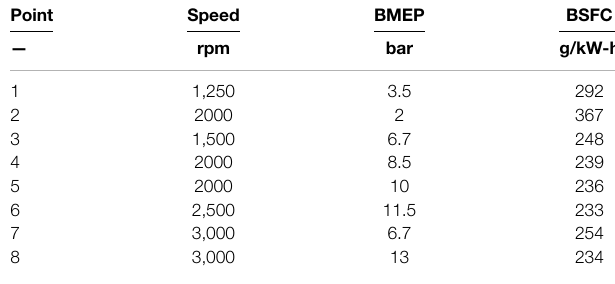
TABLE 2 | Measured BSFC at the HEDGE test